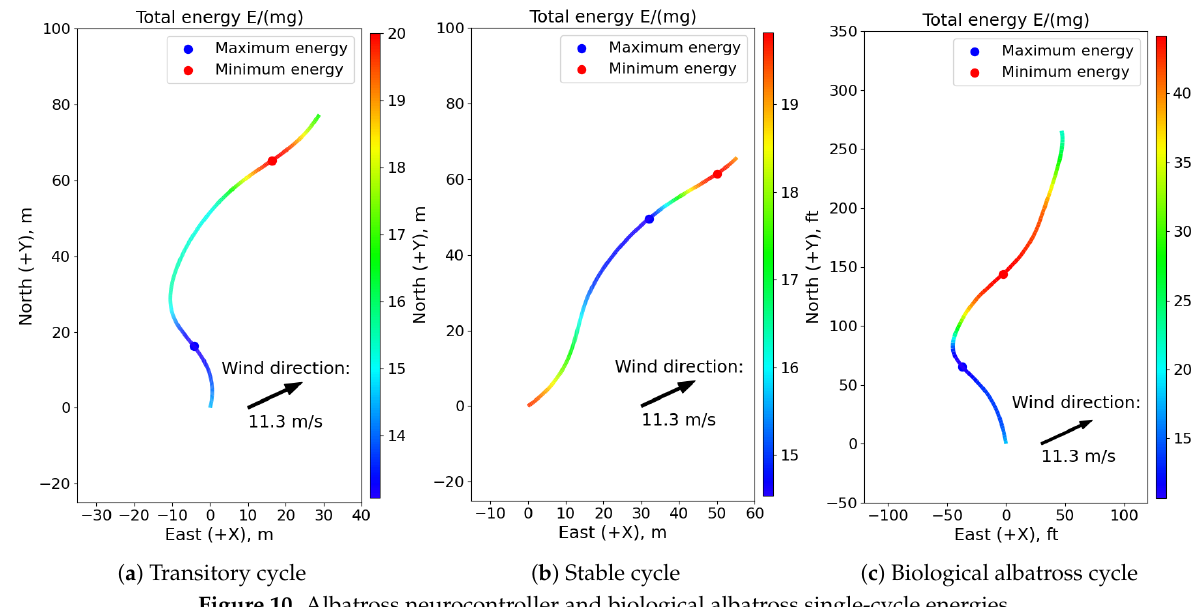
Figure 10. Albatross neurocontroller and biological albatross single-cycle energies.